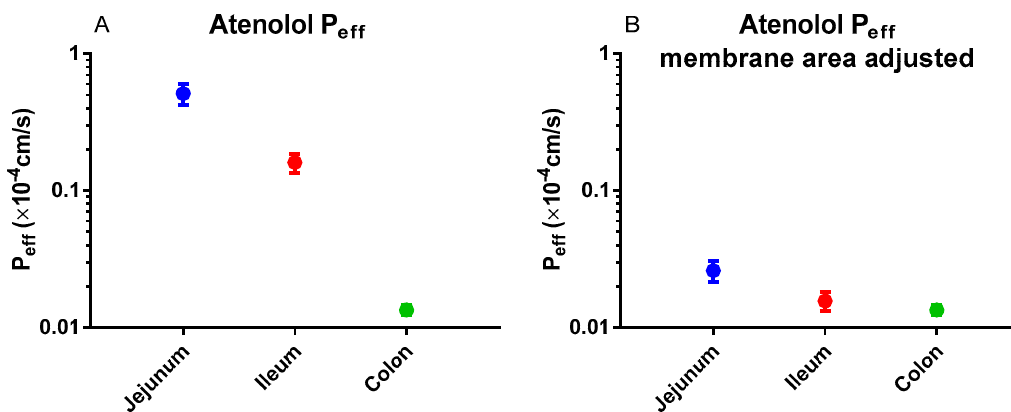
Figure 6. ( A ) Regional intestinal effective permeability (P eff ) of atenolol in humans [3]. ( B ) Surface area (villi and folds)-adjusted regional intestinal P eff values for atenolol in humans: jejunum 19-fold, ileum 10-fold, colon 1-fold [103]. Figures are remade based on historical data.